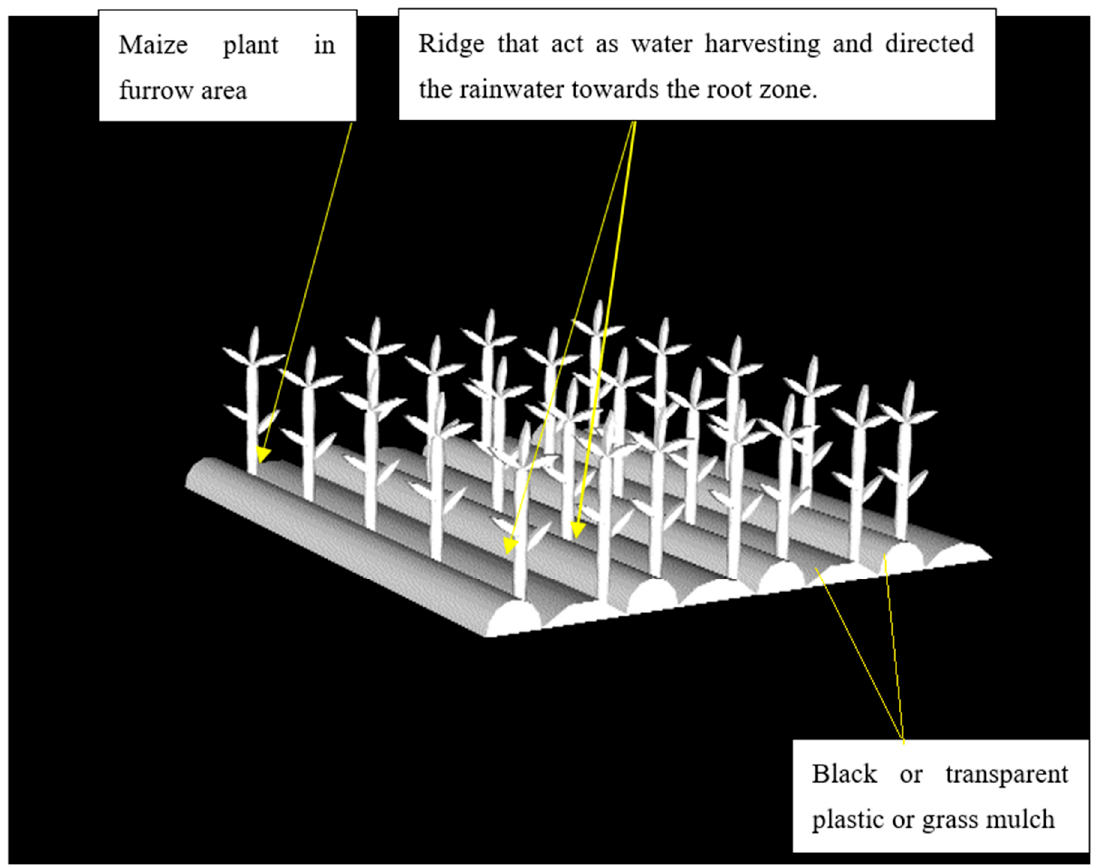
Figure 2. A schematic diagram of the field layout.